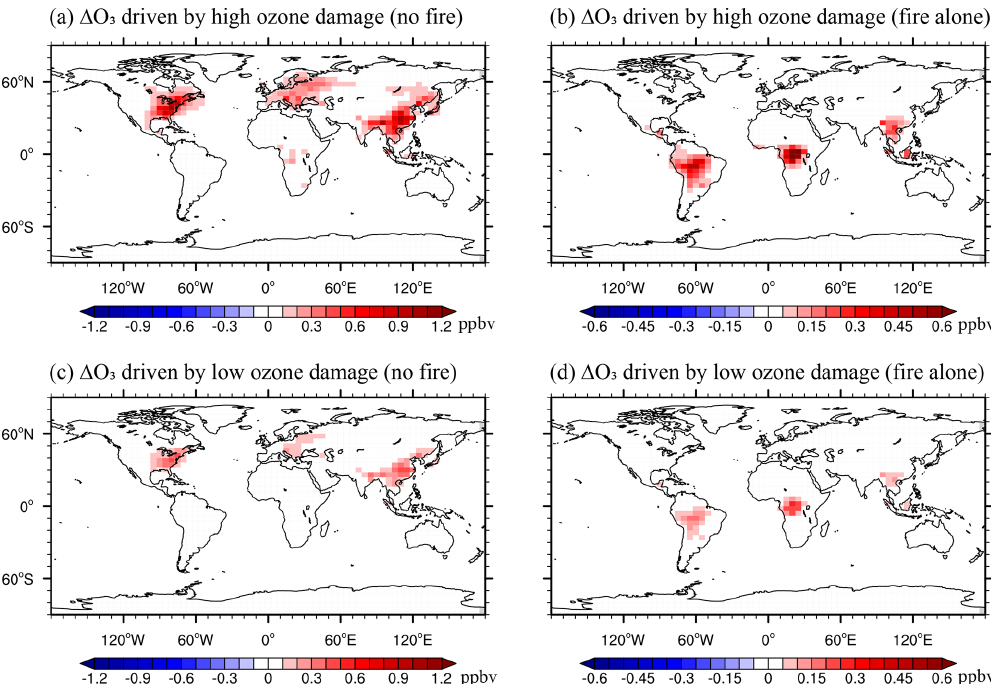
Figure 5. Annual feedback to surface O 3 caused by O 3 vegetation damage with (a, b) high and (c, d) low O 3 sensitivities. Panels (a) and (c) represent feedback by O 3 from non-fire sources, and panels (b) and (d) represent feedback by O 3 from fire emissions alone. Please note the differences in color